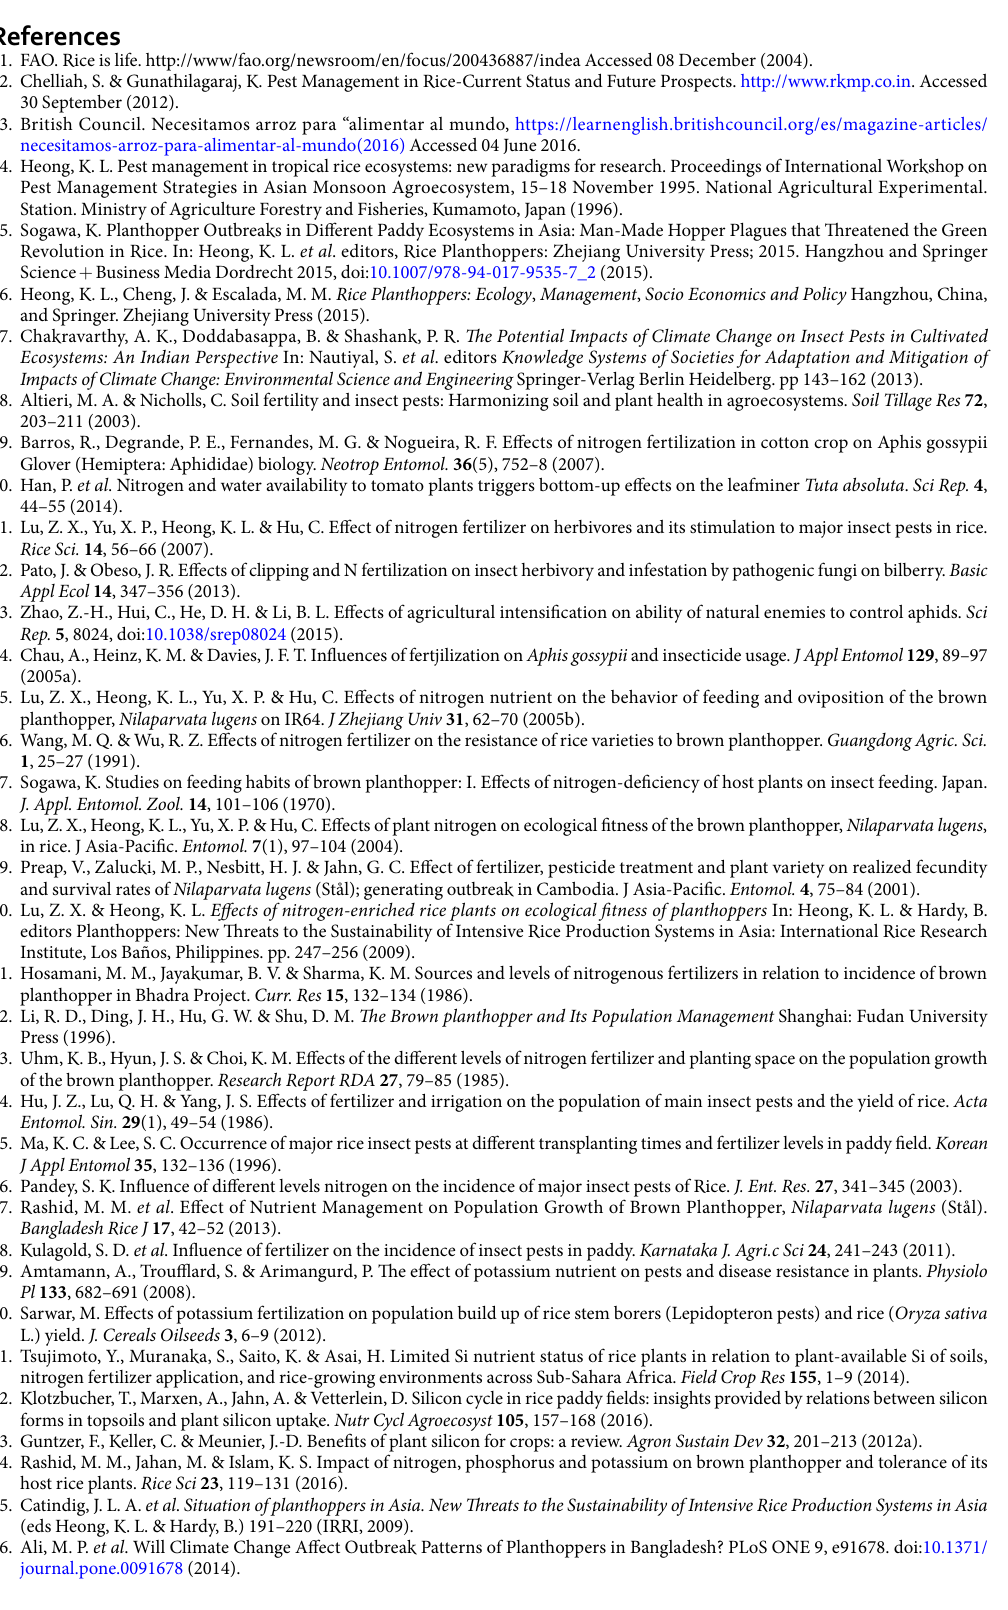
plant nutritional elements and BPH fitness traits) to visualize subtleties reported in this paper for consideration in the design of future experiments in either the net house or field plots. Several concepts (i.e., hexadecimal RGB (Red, Green, Blue) color codes) and software packages (SAS/GRAPH software (SAS Institute, Cary, NC, USA) and ArcGIS software by ESRI (Redlands, CA, USA)) combined the various results of this study to generate these stylized multi-dimensional plots 93